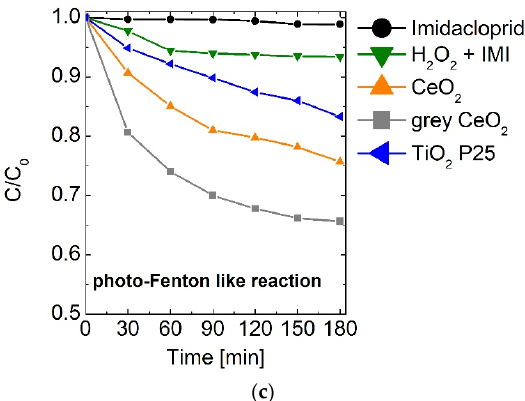
Figure 7. ( a ) Photocatalytic degradation of IMI under solar light irradiation, ( b ) Fenton-like reaction, ( c ) photo-Fenton like reaction on the analyzed samples.